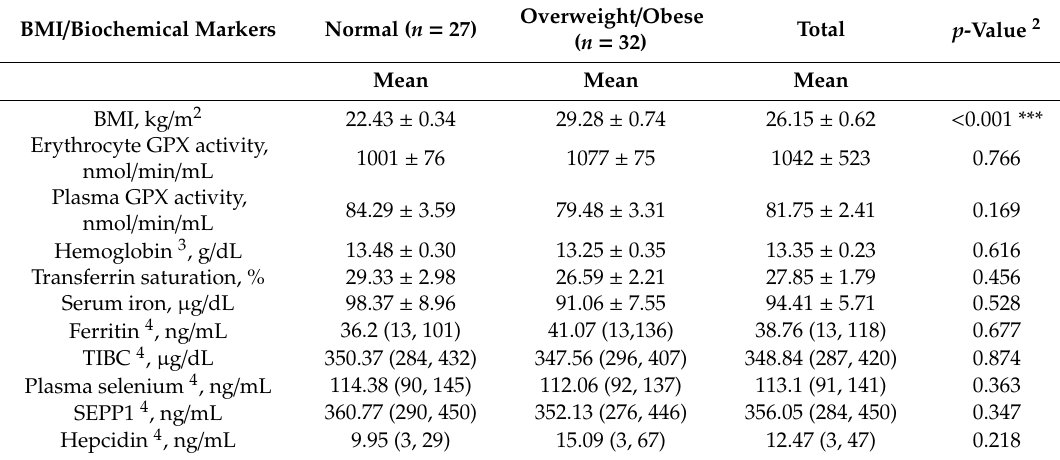
Table 2. BMI and biochemical markers among young adults with normal weight or overweight / obesity 1